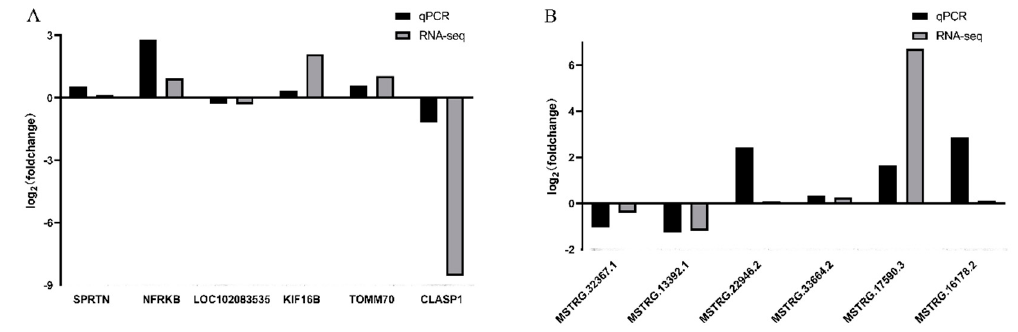
Figure 6. Validation of RNA-seq by qRCR. ( A ) qRCR validation of 6 mRNAs. ( B ) qRCR validation of 6